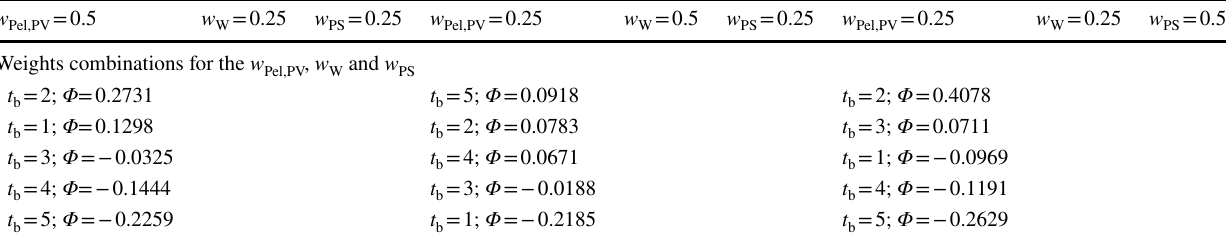
Table 4 Sensitivity analysis regarding impact of the change of criteria weights with ranks of the variants regarding balancing periods, with